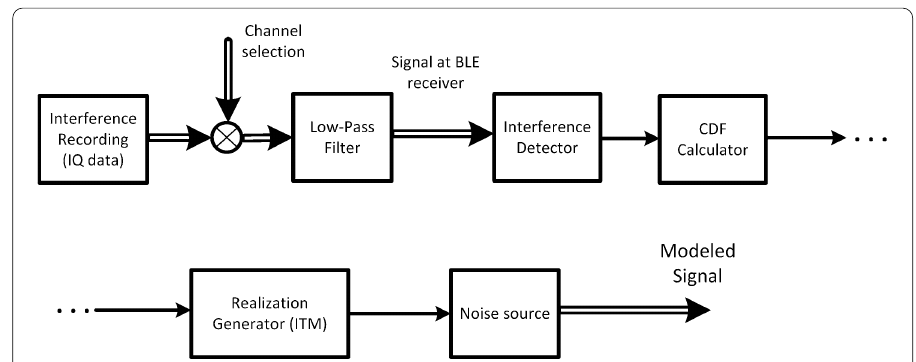
Fig. 12 Process flow graph of statistical IQ-based interference model